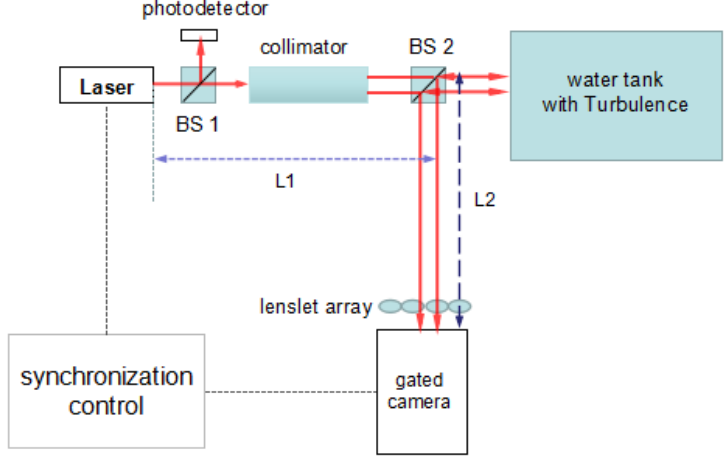
Figure 1. Schematic diagram of the gated wavefront sensing system.